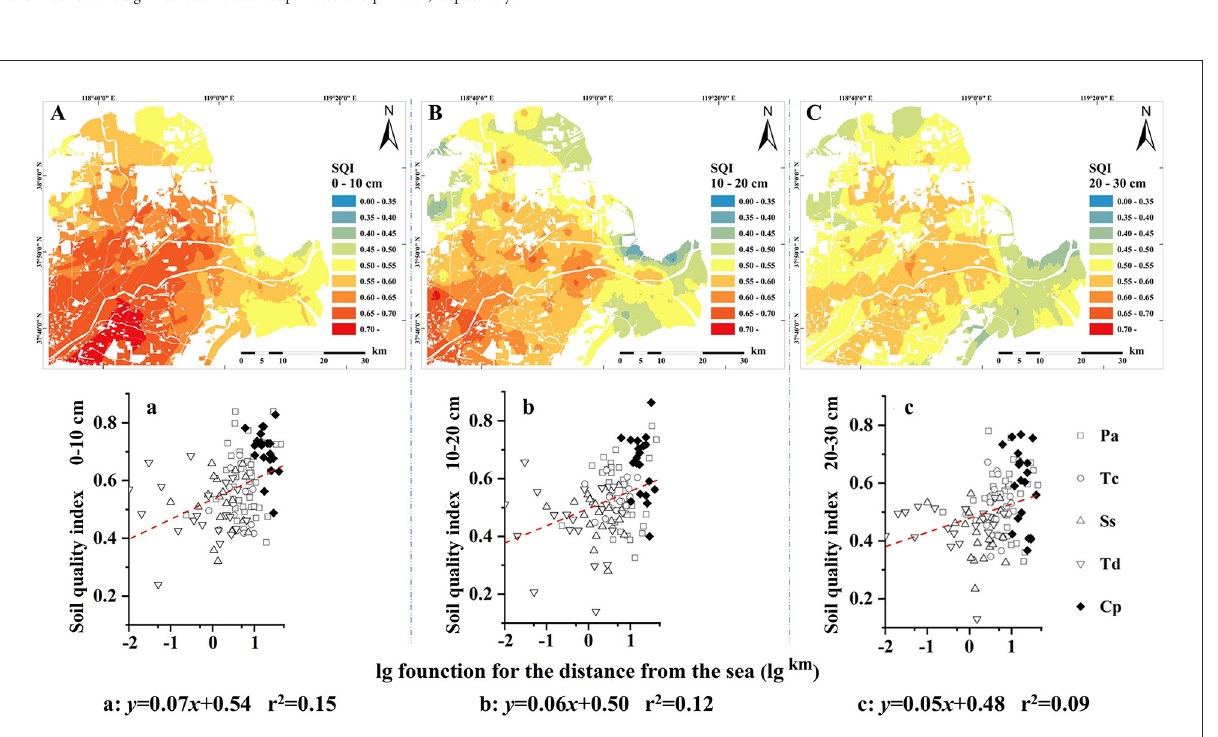
Reclaimed wetland